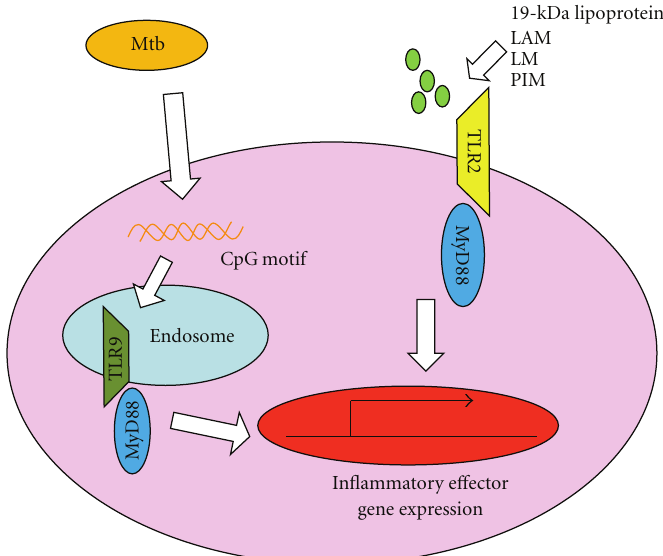
Figure 1: Recognition of mycobacteria by Toll-like receptors. TLR2 recognizes several mycobacterial-derived components. TLR9 recognizes mycobacterial DNA including the CpG motif within endosomal compartments. TLR-dependent recognition of mycobacteria induces activation of signaling pathways via the adaptor molecule MyD88, leading to activation of gene expression.